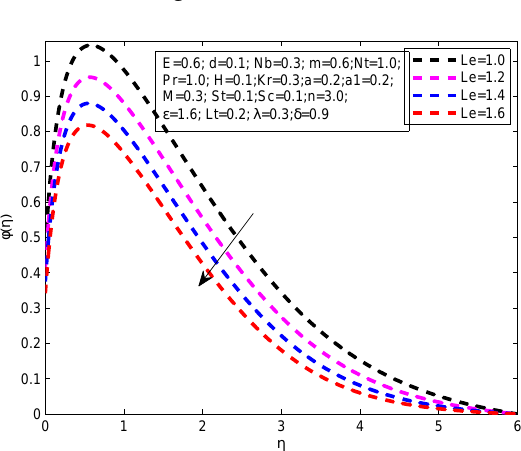
Figure 9. Variation of θ .